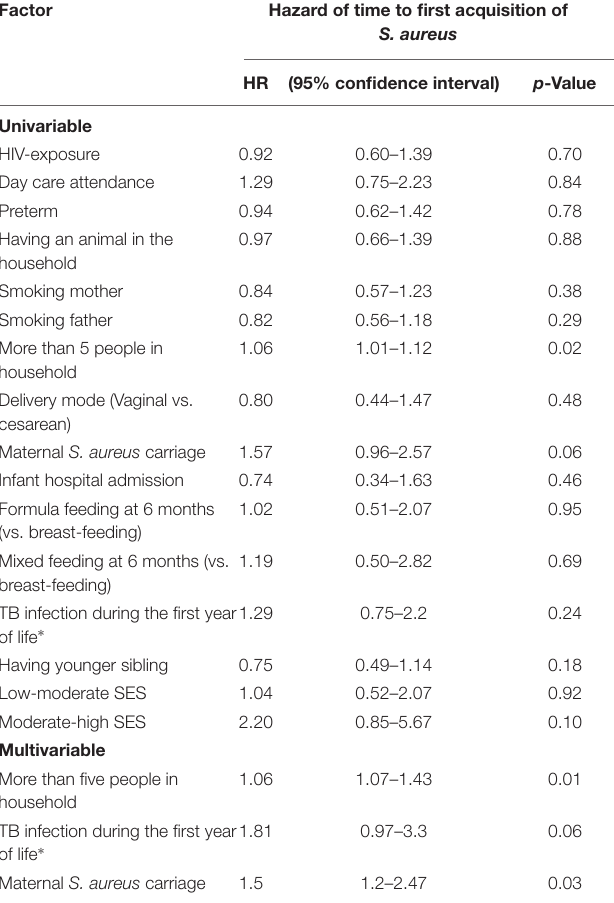
TABLE 2 | Univariable and multivariable analysis of factors associated with time to S. aureus first acquisition. Factor Hazard of time to first acquisition of S. aureus HR (95% confidence interval) p